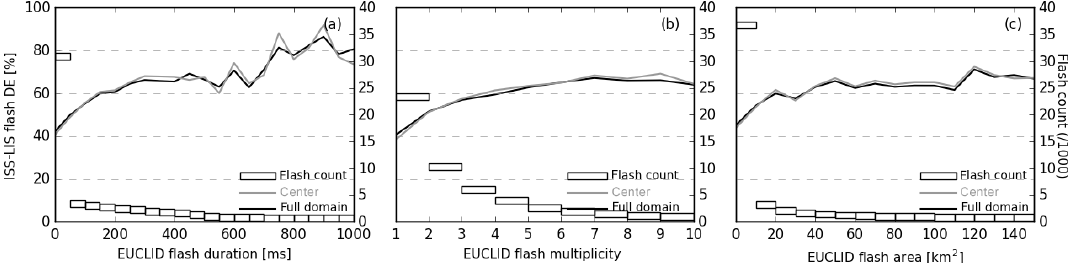
Figure 9. The distribution of ISS-LIS relative flash DE as a function of EUCLID flash characteristics such as flash (a) duration, (b) multi- plicity, and (c) area. Black lines are the results for the full domain, whereas gray lines are related to the center of EUCLID. Additionally, the ISS-LIS flash counts per interval are plotted as well.